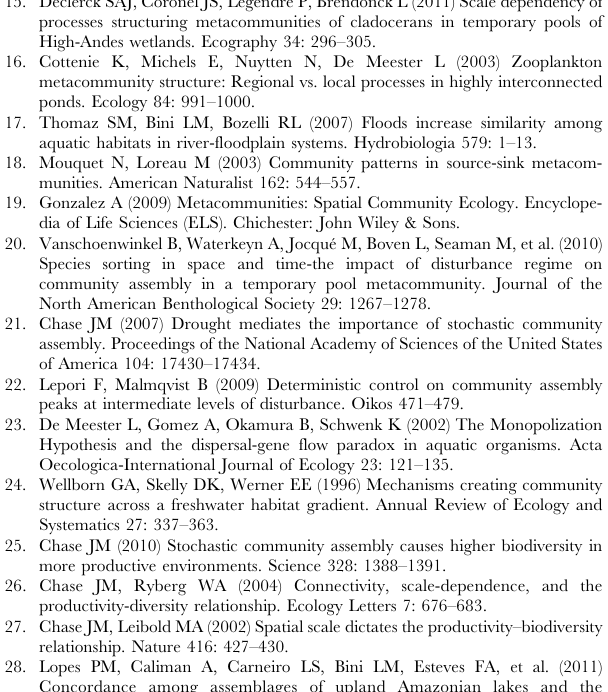
Figure S7 Local contribution to beta diversity (LCBD) for Macae´ and Caraja´s regions. Maps of Macae´ and Caraja´s regions during dry and wet seasons showing the local contributions to beta diversity (LCBD) of the zooplankton community at the study lakes. Size of the circles is proportional to the LCBD. Lakes in red have significant LCDB indices ( P , 0.05). All lakes in red are permanent lakes, except for the lakes in Macae´ 3 and Macae´ 4 labelled with T (temporary). 1= first sampling time, 2= second sampling time, 3= third sampling time, 4 =fourth sampling time. Table S1 Sampling schedule for each study region. Type of environment, date of collection and number of sampled aquatic environments ( n ) in each region, season and sampling time. Con, connected; Isol, isolated; Perm, permanent; Temp, temporary. Table S2 Species list for each region. List of species per region and lake category. Dominant species are highlighted in yellow. Tr, Pr, Ar, Ma and Ca= Trombetas, Parana´, Araguaia, Macae´ and Caraja´s, respectively. PC, TI, PI =permanent connected, temporary isolated, permanent isolated. Table S3 Linear mixed-effects models of zooplankton beta diversity measured as the mean Bray-Curtis and Simpson distances to group centroid for connectivity data. Summary of the linear mixed-effects models of zooplankton beta diversity measured as the mean Bray-Curtis (DistC BC ) and Simpson (DistC Sim ) distance to group centroid for connectivity data (connected and isolated permanent lakes from all study regions). Marginal R 2 represents the variance explained by fixed factors.